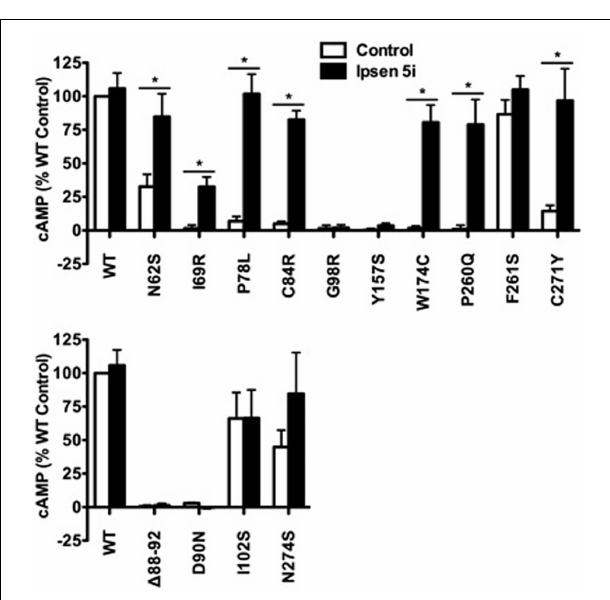
FIGURE 7 | Ipsen 5i rescued the function of intracellularly retained mutant MC4Rs in N1E-115 cells . N1E-115 cells transiently expressingWT or mutant MC4Rs were treated with 10 − 6 M Ipsen 5i or DMSO as control. The results are expressed as % DMSO-treatedWT cAMP production after correction of the cAMP production in cells expressing the empty vector. Results are shown as mean ± SEM of at least three independent experiments. See the legend to Figure 5 for